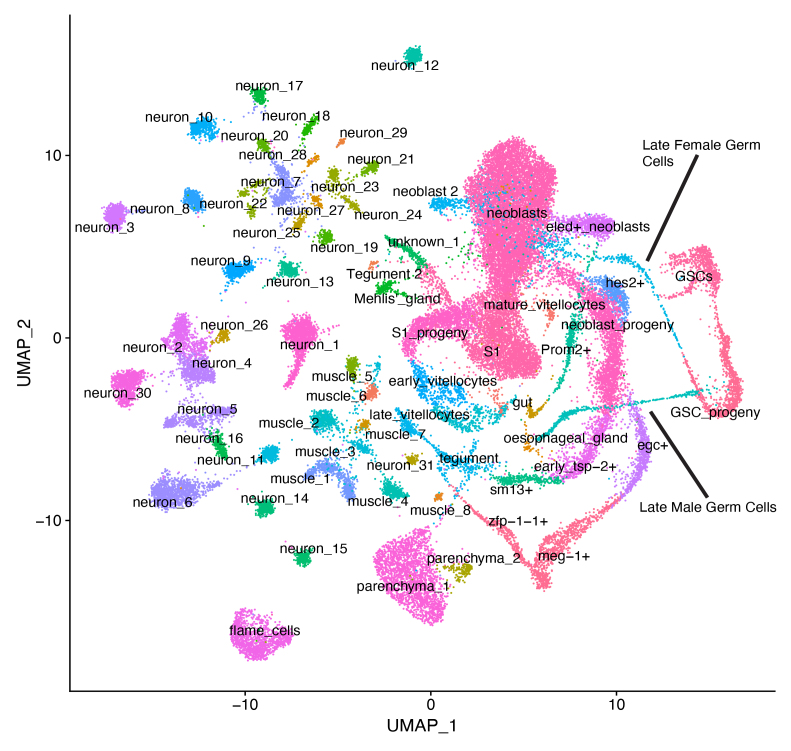
Uniform manifold approximation and projection (UMAP) view of all identifiable cellular clusters in adult schistosomes. The 68 clusters identified by Wendt et al. (2020) are projected here with labels. Cells are derived from sexually-mature adult male and female worms as well as sexually immature (developed in the absence of males) females. Reference: Wendt, G., Zhao, L., Chen, R., Liu, C., O’Donoghue, A.J., Caffrey, C.R., Collins, J.J., 2020. A single-cell RNAseq atlas of the pathogenic stage of Schistosoma mansoni identifies a key regulator of blood feeding. Science 369 (6511), 1644-1649.